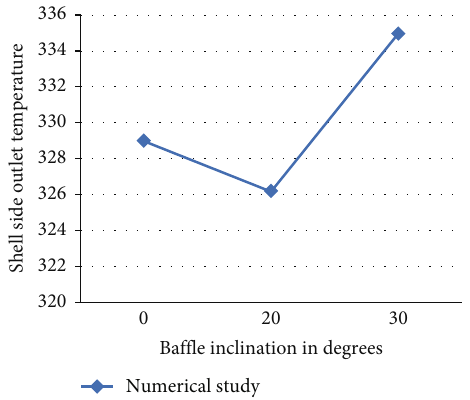
Figure 15: E ff ect of shell side outlet temperature for alumina with di ff erent ba ffl e